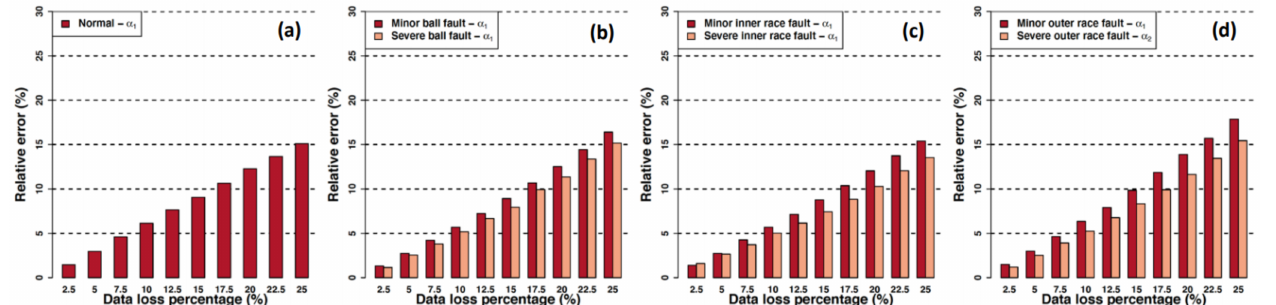
Figure 13. Relative errors in the scaling exponent ( α 1 ) due to data loss in the bearing vibration signals: ( a ) normal, ( b ) ball fault, ( c ) inner race fault, ( d ) outer race